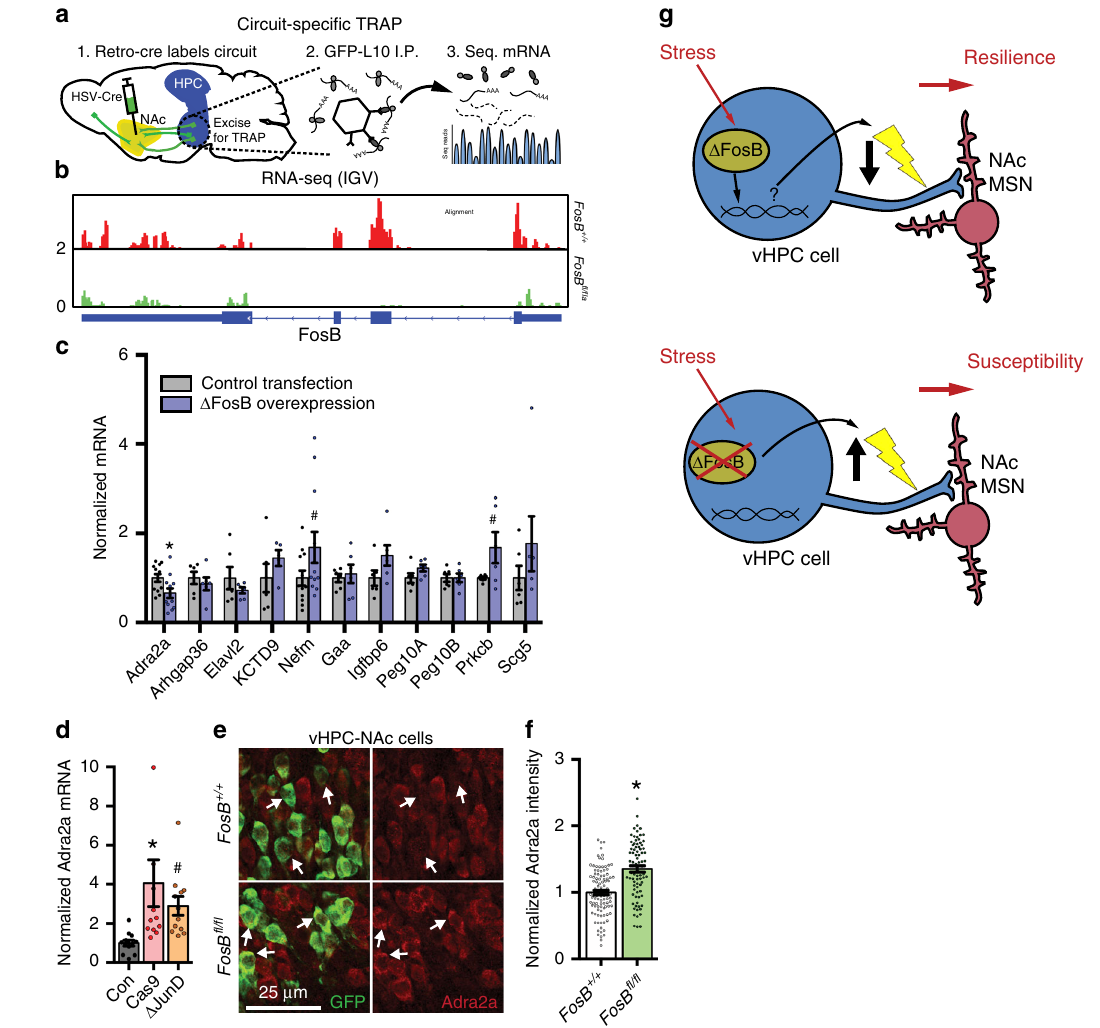
Fig. 5 Δ FosB orchestrates gene expression in NAc-projecting vHPC neurons. a Experimental design for circuit-speci fi c TRAP. Retrograde Cre vector is injected into NAc and vHPC is harvested for immunoprecipitation of ribosomes from L10-GFP-expressing NAc-projecting cells and sequencing of actively translating mRNA. b Sequencing reads (red or green peaks) for FosB gene (exons indicated by thick blue bars beneath graph) from WT (FosB + / + ) and FosB KO ( FosB fl / fl ) vHPC-NAc neuron mRNA. c Δ FosB overexpression in Neuro2A cells regulates mRNA expression of some TRAP-identi fi ed target genes. * P = 0.0240 for Adra2a , # P = 0.0914 for Nefm , # P = 0.0815 for Prkcb (independent samples t -test compared to Control Transfection; Adra2a n = 12 plates/ group; Arhgap36 n = 6; Elavl2 n = 6; Kctd9 n = 5 – 6; Nefm n = 12; Gaa n = 6; Igfbp6 n = 6; Peg10a n = 6; Peg10b n = 6; Prkcb n = 6; Scg5 n = 6). d Adra2a mRNA expression is increased in Neuro2A cells transfected with Δ JunD or FosB -speci fi c gRNA and Cas9 (Cas9). * P = 0.0133, # P = 0.0822 ( n = 12 wells/ group; one-way ANOVA with Holm – Sidak post-tests versus control). e Representative coronal vHPC images (20X) showing NAc-projecting neurons expressing GFP (green) and α 2AAR (red) in fl oxed FosB KO ( FosB fl / fl ; bottom panels) and WT ( FosB + / + ; top panels) mice. f Intensity of α 2AAR expression in NAc-projecting GFP-labeled is decreased by FosB KO ( FosB fl / fl ). * P < 0.0001 ( n = 100 FosB + / + cells, n = 83 FosB fl / fl cells; independent samples t -test compared to FosB + / + ). e Proposed model: in resilient mice, stress strongly induces Δ FosB in vHPC-NAc neurons initiating gene expression that underlies a protective decrease in excitability of the projection; in susceptible mice, a lack of FosB expression allows stress-associated differential gene expression to keep vHPC-NAc excitability high, driving social avoidance. All graphs are represented as mean ± Δ FosB transcriptional regulation may reveal myriad druggable pathways for the systemic or circuit-speci fi c treatment of depression, potentially for symptoms of social withdrawal.